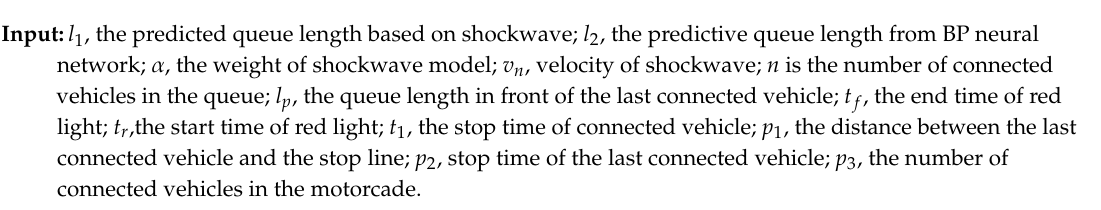
Algorithm: Queue Length Sensing Algorithm at Signalized